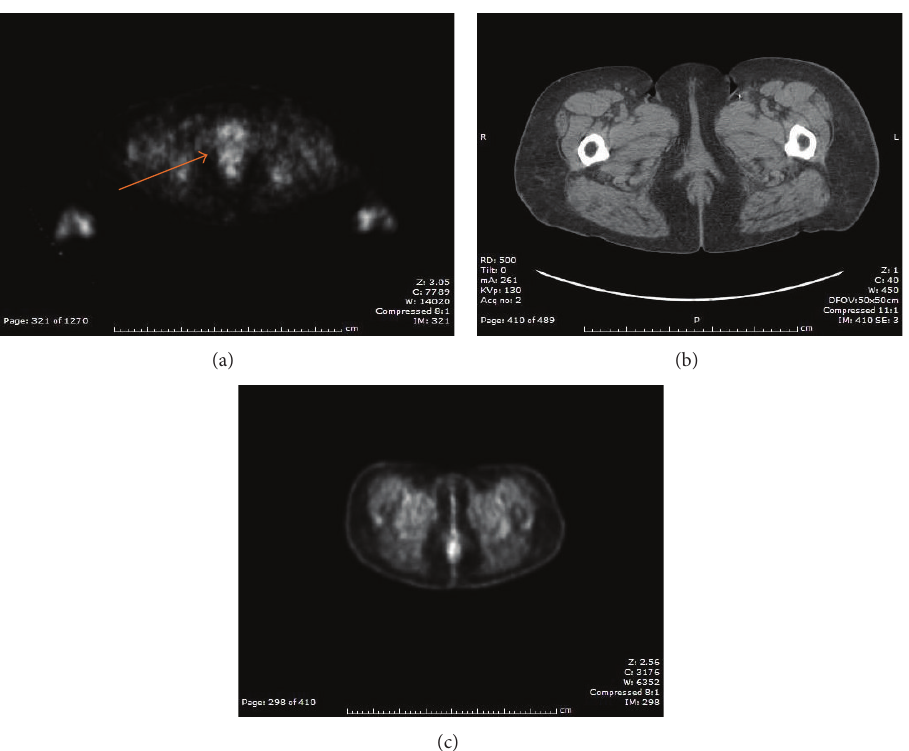
Figure 2: (a) PET CT before treatment. Arrow shows metabolically active area referring to vulvar lesion. (b) CT correlation. (c) PET CT after